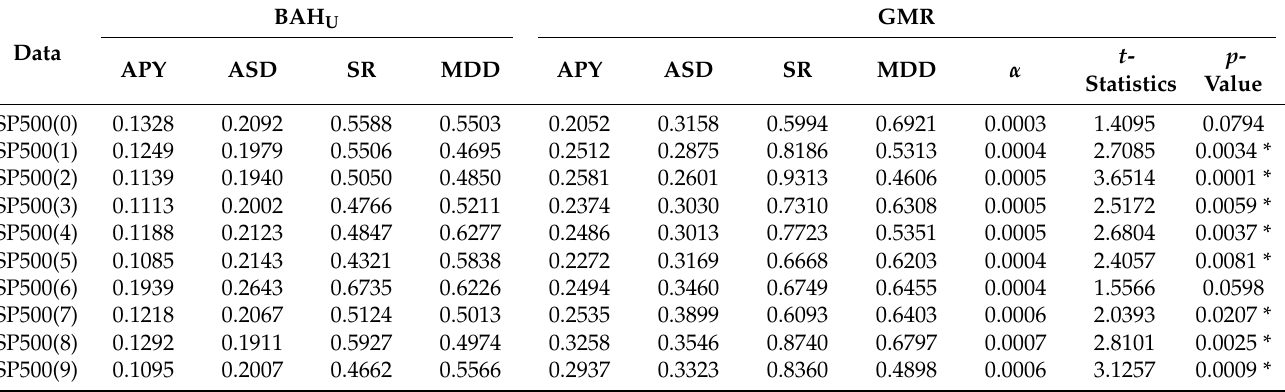
Table 3. APY, ASD, SR, MDD, and α , t -statistic, and p -value of GMR on the S&P 500 datasets. The transaction costs were not considered, and the p -value less than 0.05 are denoted with an asterisk.